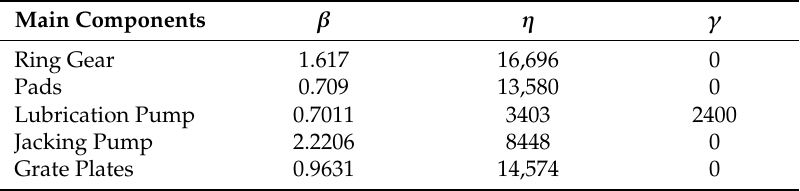
Table 9. Weibull parameters for each of the critical component failure modes.